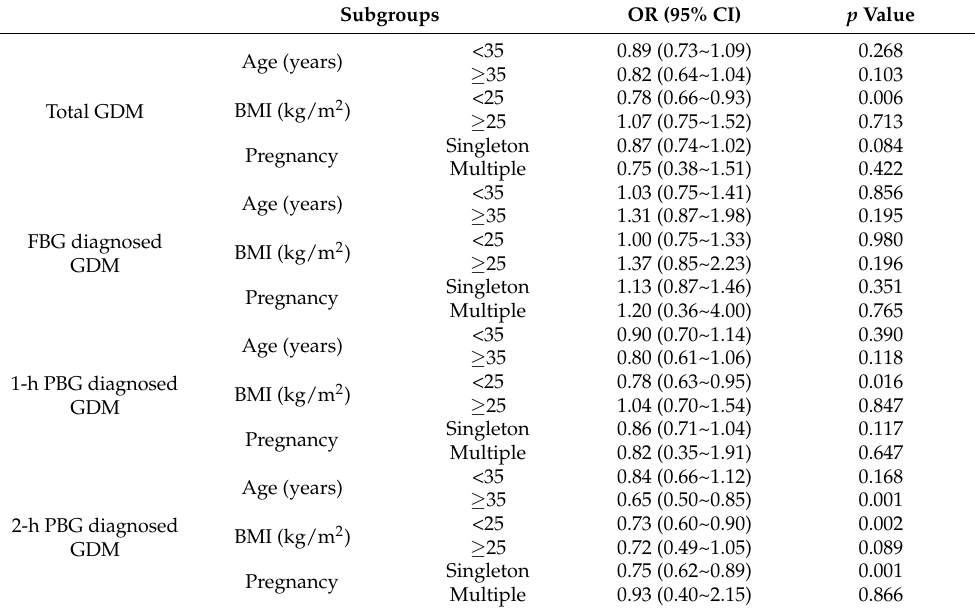
Table A1. Sensitivity analysis: potential factors for the impact of folic acid supplementation during early pregnancy on